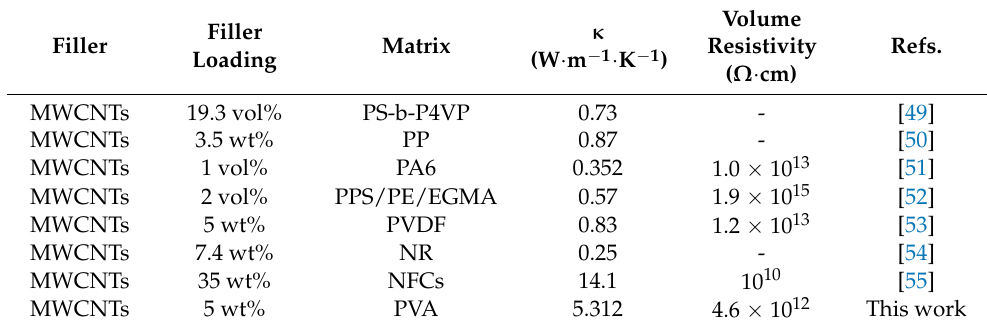
Table 1. Thermal conductivity of polymer composites with MWCNTs.